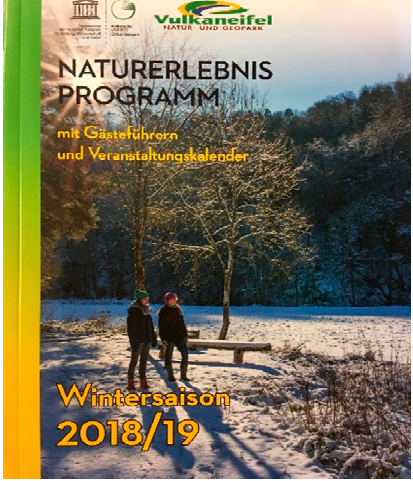
Figure 10. Vulkaneifel UGGP Program Autumn/Winter 2018/2019.